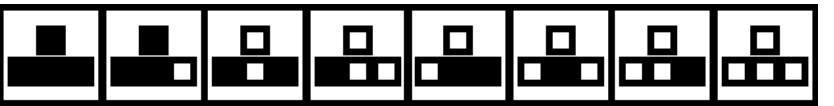
Figure 12. Rule 192. Only the first and second stages lead to a black cell, similar to our hypothesis on the signal flow